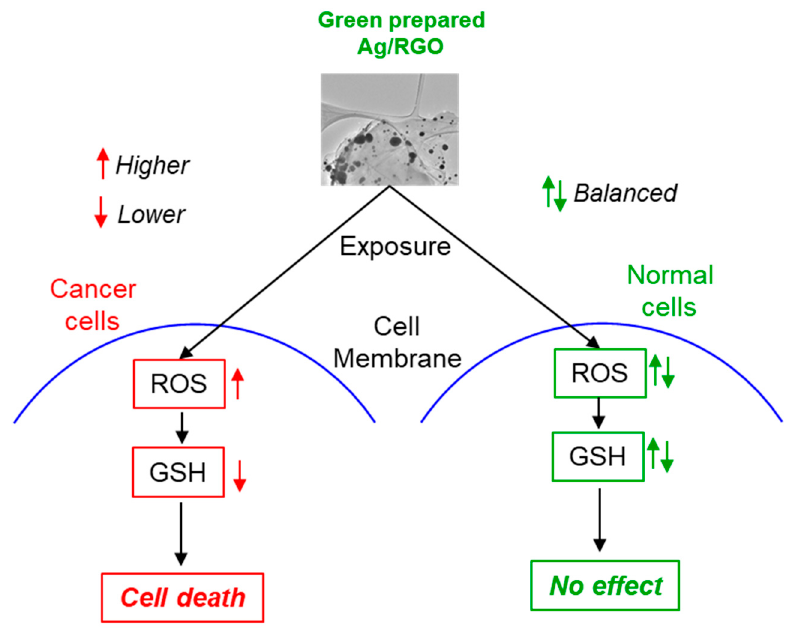
Figure 10. Possible mechanism of anticancer performance of Ag/RGO NCs.